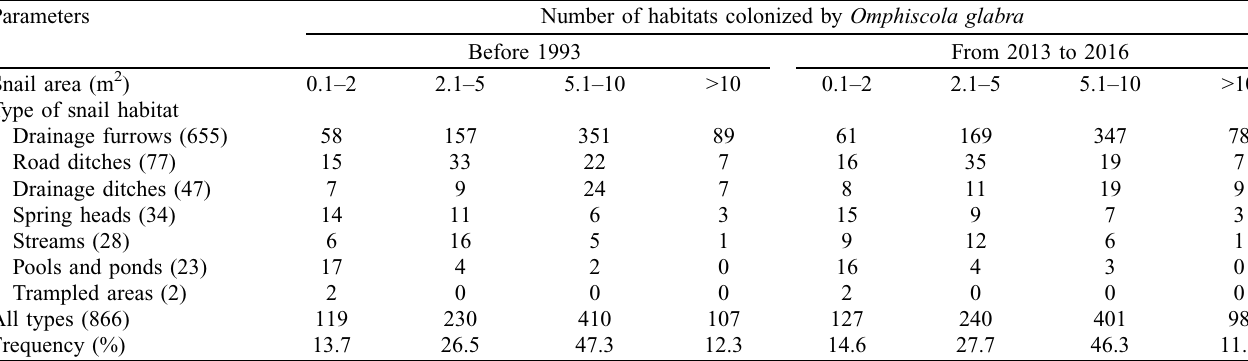
Table 4. Distribution of 866 habitats colonized by Omphiscola glabra on the 162 farms before 1993 and in 2013–2016 in relation to the type and area of habitat. The total number of snail habitats is given after each type of habitat (first